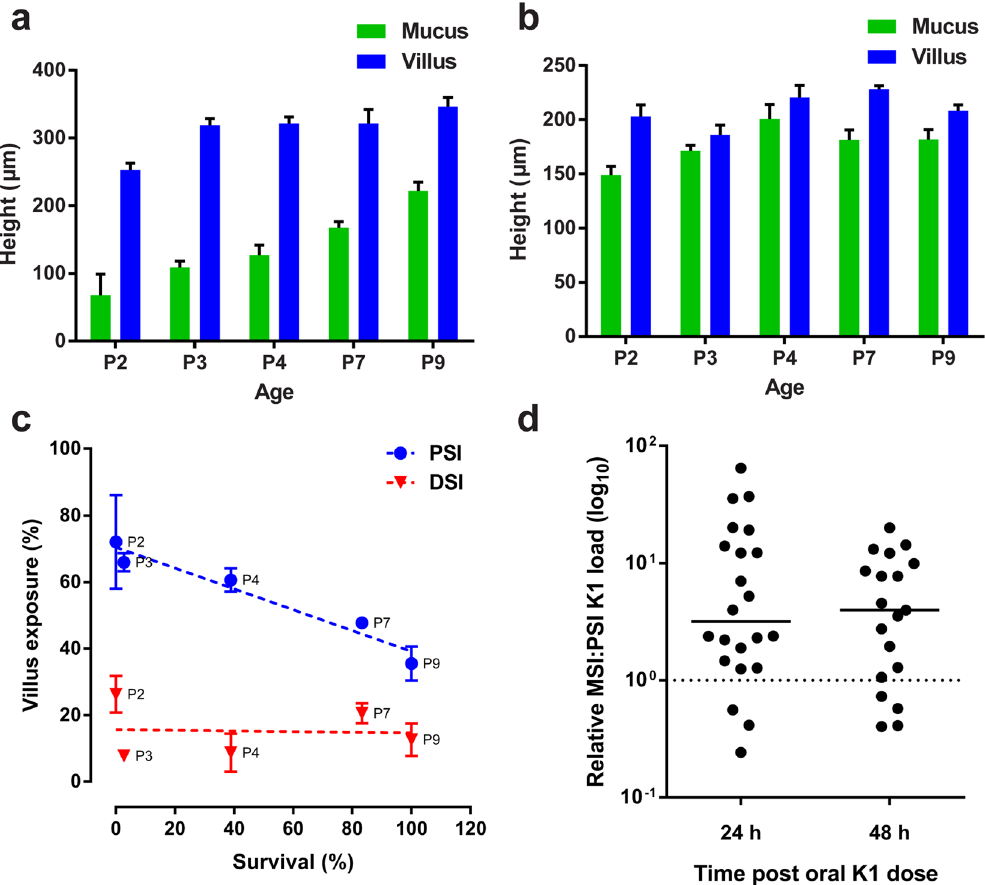
Figure 7. DSI mucus layer maturation and PSI bacterial load may form the basis of E. coli K1 invasive region- selectivity. Ex-vivo quantification of PSI ( a ) and DSI ( b ) mucus layer and villus height from P2-P11; n = 4 animals, mean ± SEM. ( c ) Correlation between PSI and DSI villus exposure (proportion of villus not covered by mucus layer) and survival between P2-P9 after initiation of E. coli A192PP colonization at P2; n = 4 animals, mean ± SEM, linear regression of data indicated by dashed lines. ( d ) Quantification of relative E. coli K1 load in the MSI compared to PSI (represented by dashed line) of neonatal animals 24 and 48 h after colonization at P2; line is median, n = 19–22 animals per